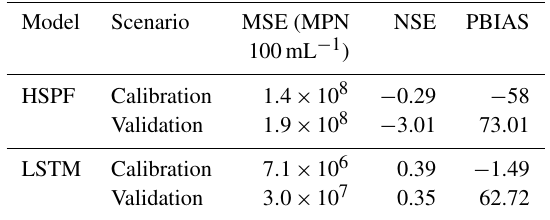
Table 4. Performance metrics of HSPF and LSTM for E. coli con- centration